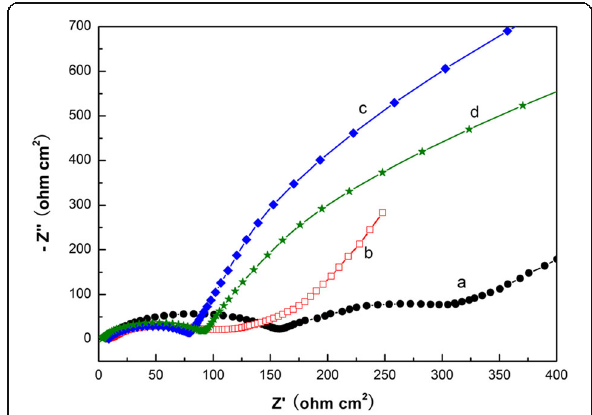
Fig. 8 Nyquist plot of Li/MnO 2 cells at open-circuit voltage. ( a ) caddice-clew-like MnO 2 sample. ( b ) Urchin-like MnO 2 sample. ( c ) 50 μ L PPy-coated caddice-clew-like MnO 2 sample. ( d ) 30 μ